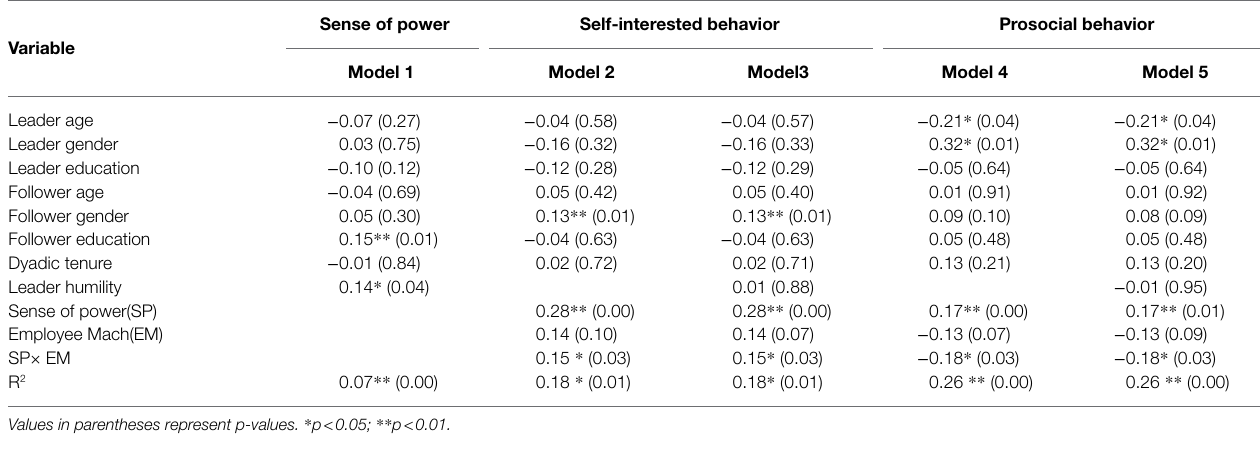
TABLE 3 | Results of hierarchal regression.